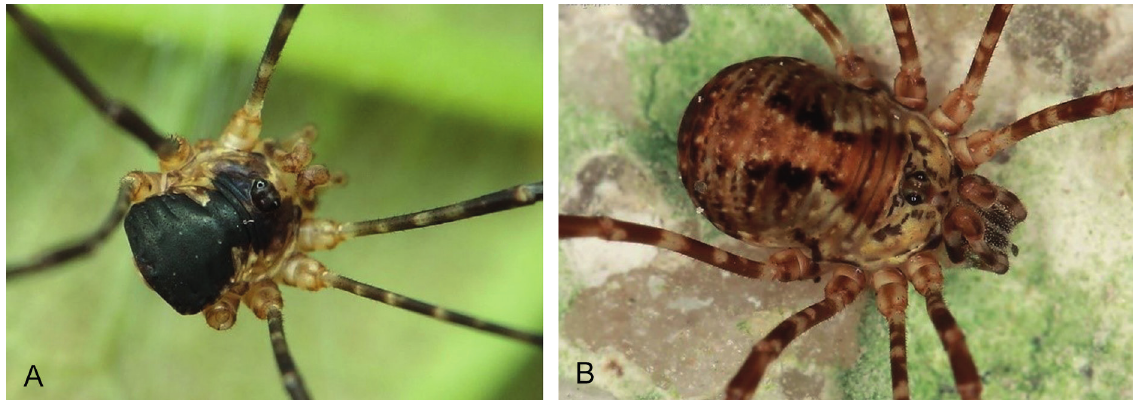
Fig. 15. Dorsal view of Dicranopalpus gallaecicus sp. nov. in situ. A . Male from Villalba (Photo no. 783897, M. Sanmartín). B . Female from Cerdedo (Photo no. 985496,